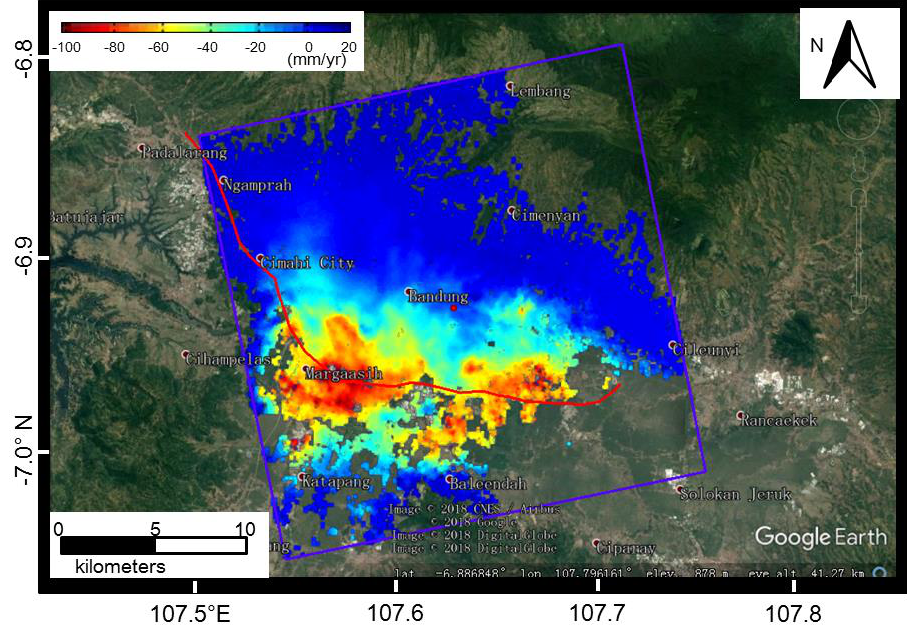
Figure 5. Linear deformation trends of Sentinel-1 A/B along the line of sight (LOS) direction from 12 October 2014 to 7 December 2017. There are two major subsiding centers that are located in Margaarish Town. The color bar ranges from − 100 to 20 mm/yr. The red point highlights the spatial reference points for PSI analysis.